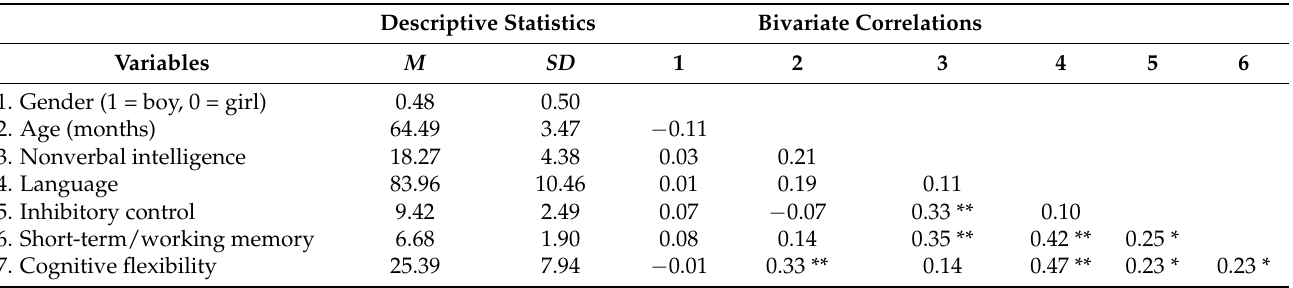
Table 1. Descriptive statistics and correlations between measures. Descriptive